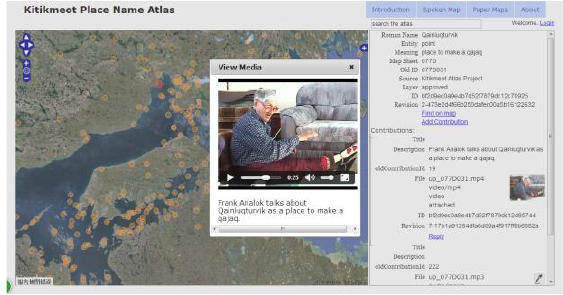
Figure 1. An Example of Cybercartography